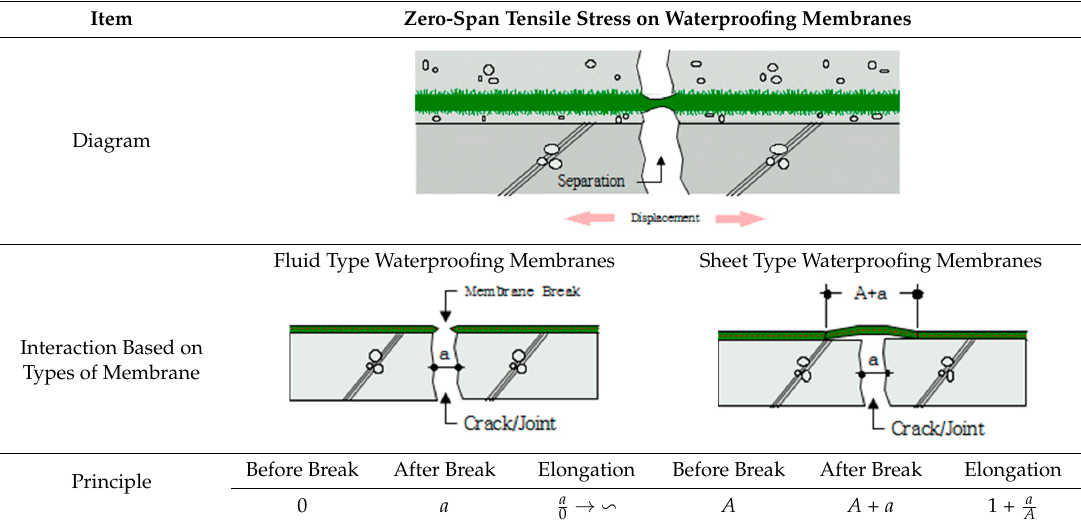
Table 2. Zero-span tensile stress mechanism of waterproofing membrane on concrete joint.